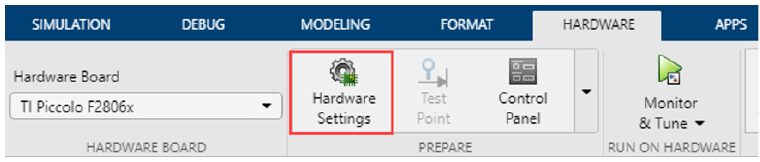
Figure 4. Model of IM control with measurement of signals on IGBT transistors gates forming PWM.